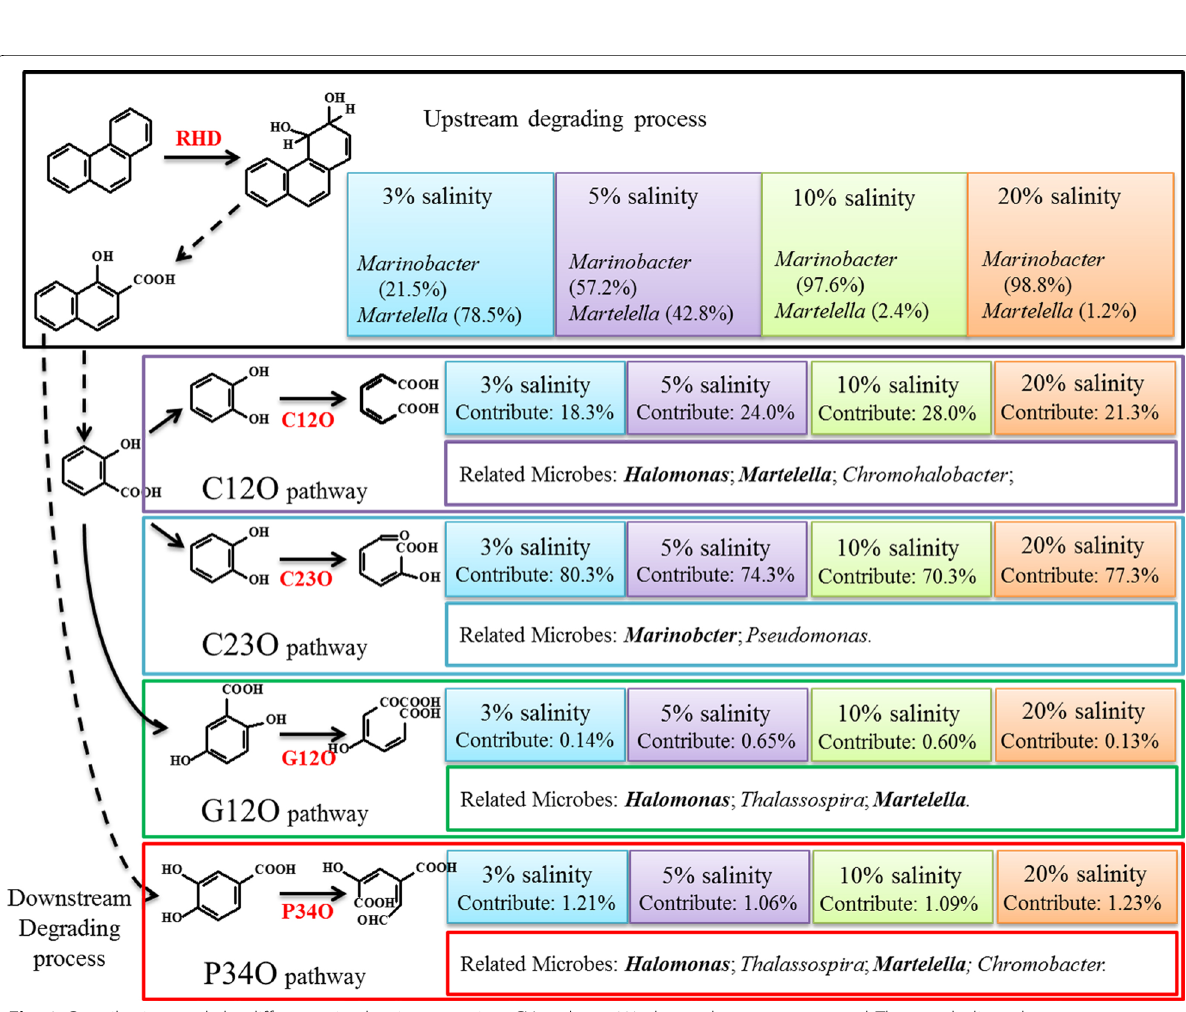
Fig. 6 Contribution made by different microbes in consortium CY-1 when 50% phenanthrene was removed. The metabolic pathways were illustrated by the combination of the result obtained from intermediates detection and catabolic gene clone libraries. Solid arrow indicates a single reaction while broken arrow represents two or more transformation steps. Contribution made by Marinobacter and Martelella in the upstream degrading process was calculated by the abundance of these two genera in community structure. The contribution of each downstream pathway was calculated by the copies of each catabolic gene quantified from total RNA. The related microbes were summarized from the clone libraries and isolated pure cultures. Dominant genera in each downstream pathway which were determined by the proportion of catabolic gene in clone librar- ies and the abundance in community structure were shown in